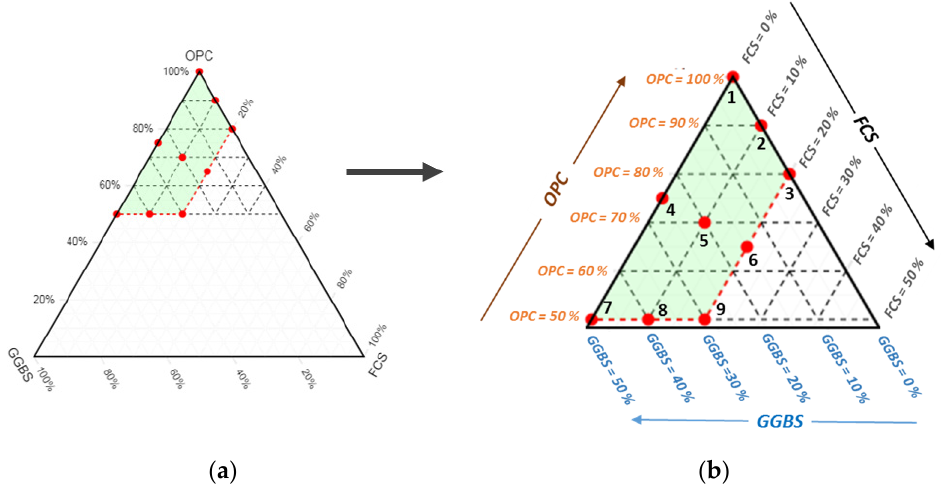
Figure 3. ( a ) Studied experimental mix designs. ( b ) Selected experimental mix